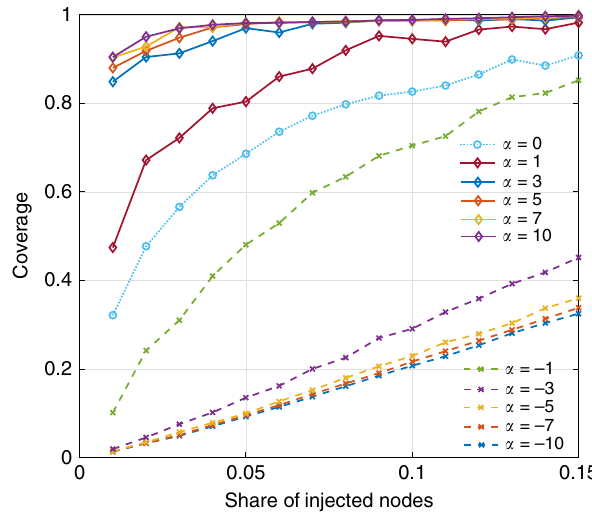
Fig. 5 Coverage as a function of α and share of injected nodes in total network of 4049